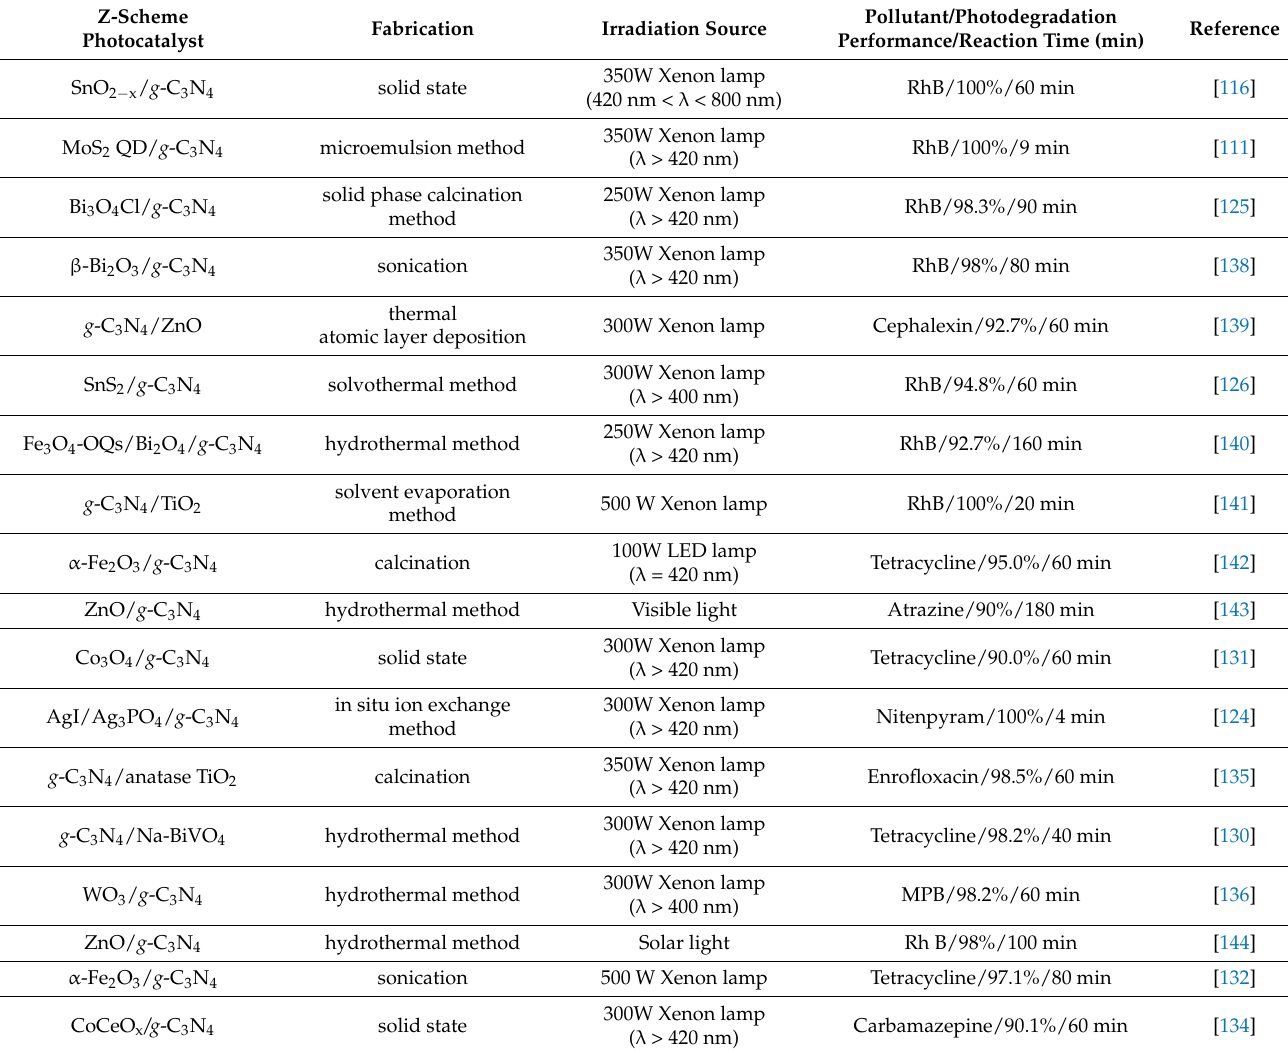
Table 1. g-C 3 N 4 -based direct Z-scheme photocatalysts for pollutant remediation. Z-Scheme